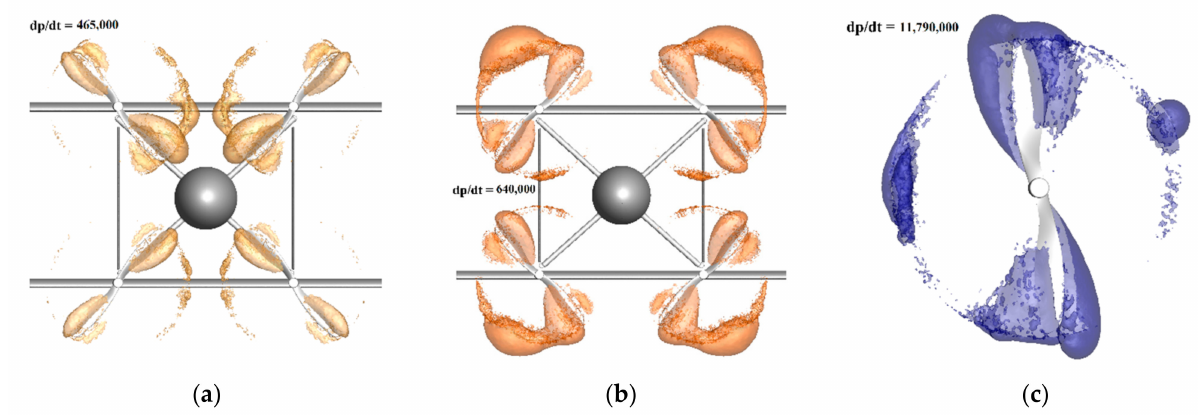
Figure 15. Snapshot of iso-surface of pressure time-derivative: ( a ) CRC-3 at γ = 45 ◦ ; ( b ) CRC-3 at γ = 45 ◦ ; ( c ) Isolated propeller at an arbitrary phase